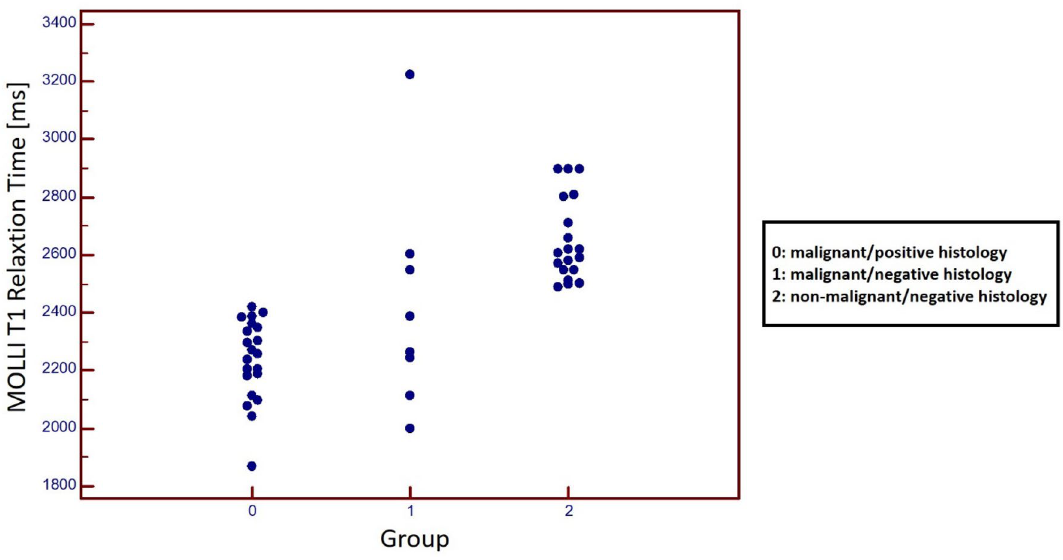
Figure 3. Graphs with individual plotted values show distribution of MOLLI T1 relaxation time in effusions from patients with known malignancy and positive histology/cytology (Group 0), effusions from patients with known malignancy but negative histology/cytology (Group 1) and effusions from patients without a known malignancy and negative histology/cytology (Group 2). Individual values are represented as single colored dots. One-way ANOVA for intergroup comparison showed T1 relaxation times differed between all groups (Group 0: 2237.1 ± 136.9 ms; Group 1: 2423.3 ± 357.4 ms; Group 2: 2650.5 ± 138.5 ms) ( p < 0.001; post hoc test for all intergroup comparisons: < 0.05).